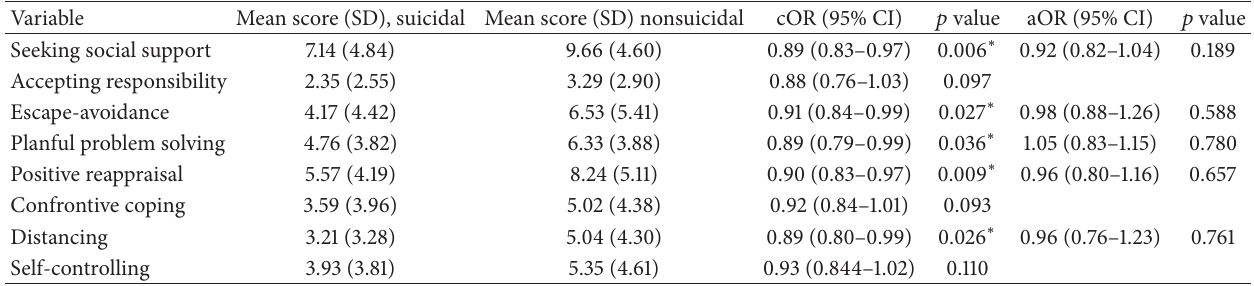
Table 3: Relationship between ways of coping and suicidal ideation and attempts among HIV infected patients in HIV clinics in Mbarara, July–October 2009 ( 𝑁 = 317